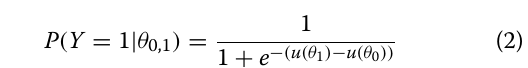
At the heart of this modeling, the w vector for a par- ticipant quantifies the abstract moral values that the indi- vidual holds for different features (for example, the value